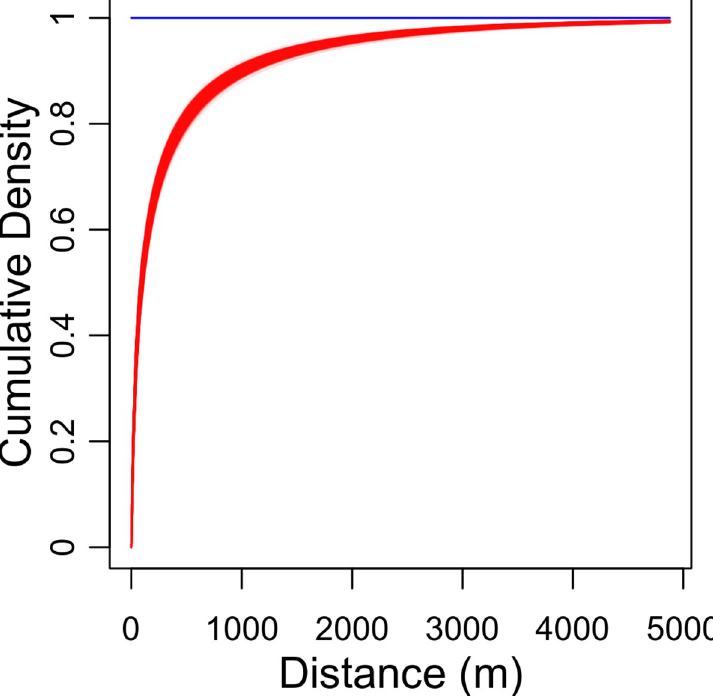
Fig 6. Estimated dispersal kernel for the sharka epidemic. The posterior marginal cumulative distribution function, F 1 D , of the fitted dispersal kernel, obtained for κ = 11 (i.e. the number of introduction patches maximising the Fisher information). The plotted posterior distribution was obtained from 4000 MCMC samples. One line is plotted per